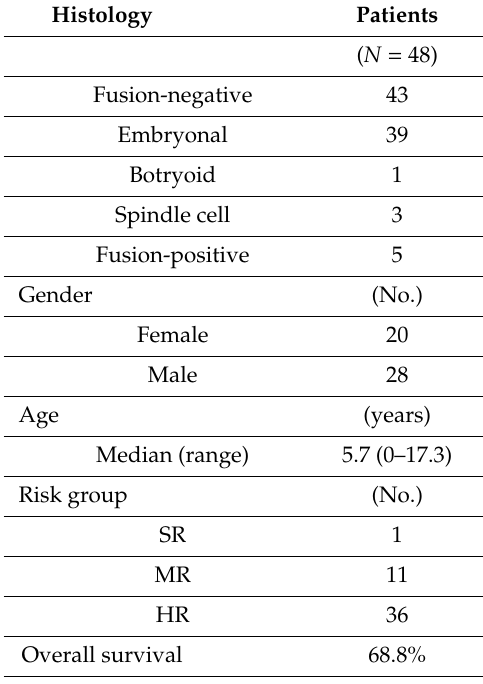
Table 1. Clinicopathologic characteristics of the studied patients diagnosed with rhabdomyosarcoma (SR, standard-risk; MR, medium-risk; HR, high-risk; No, number).